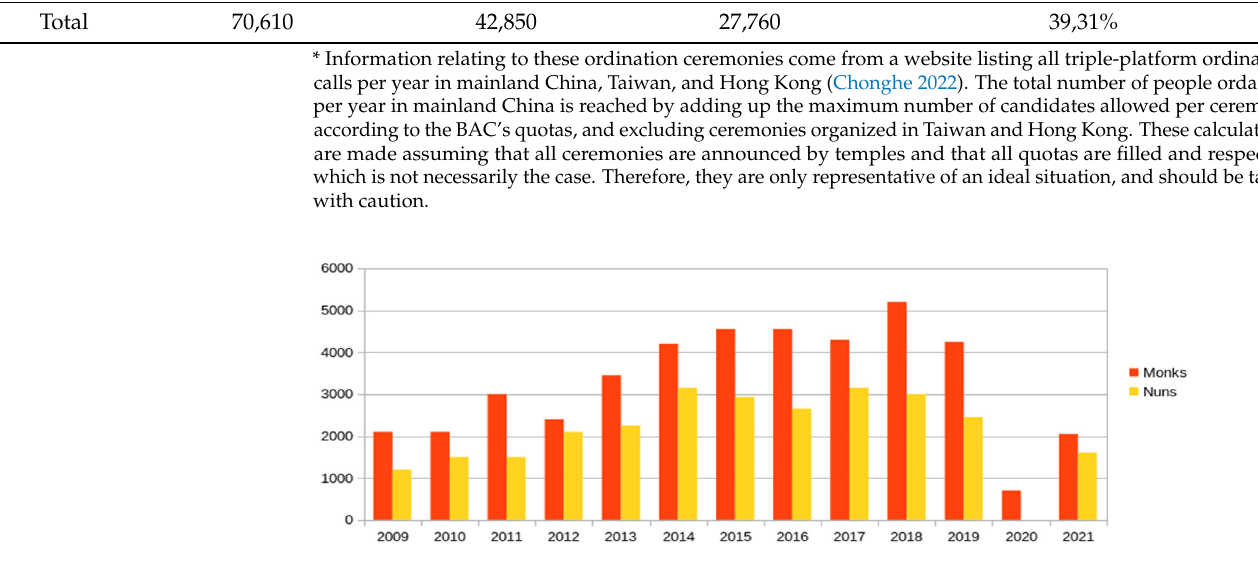
Figure 1. Number of male and female monastics’ official ordination ceremonies per year since 2009 (source: author). Table 1. Official ordination numbers per year since 2009 *.